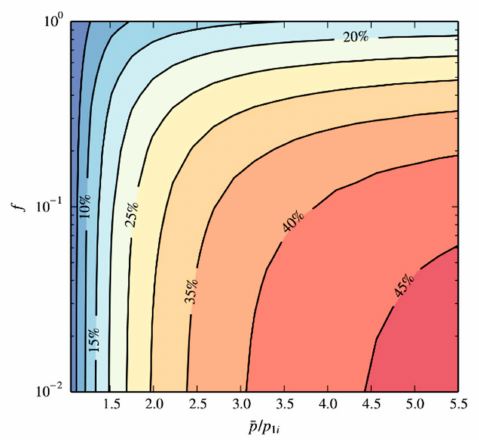
Figure 12. The relative error in the calculated permeability due to ignoring gas compressibility. For systems with a smaller dimensionless number f , when the system initial pressure ratio is large, ignoring the gas compressibility leads to a larger error in the calculated